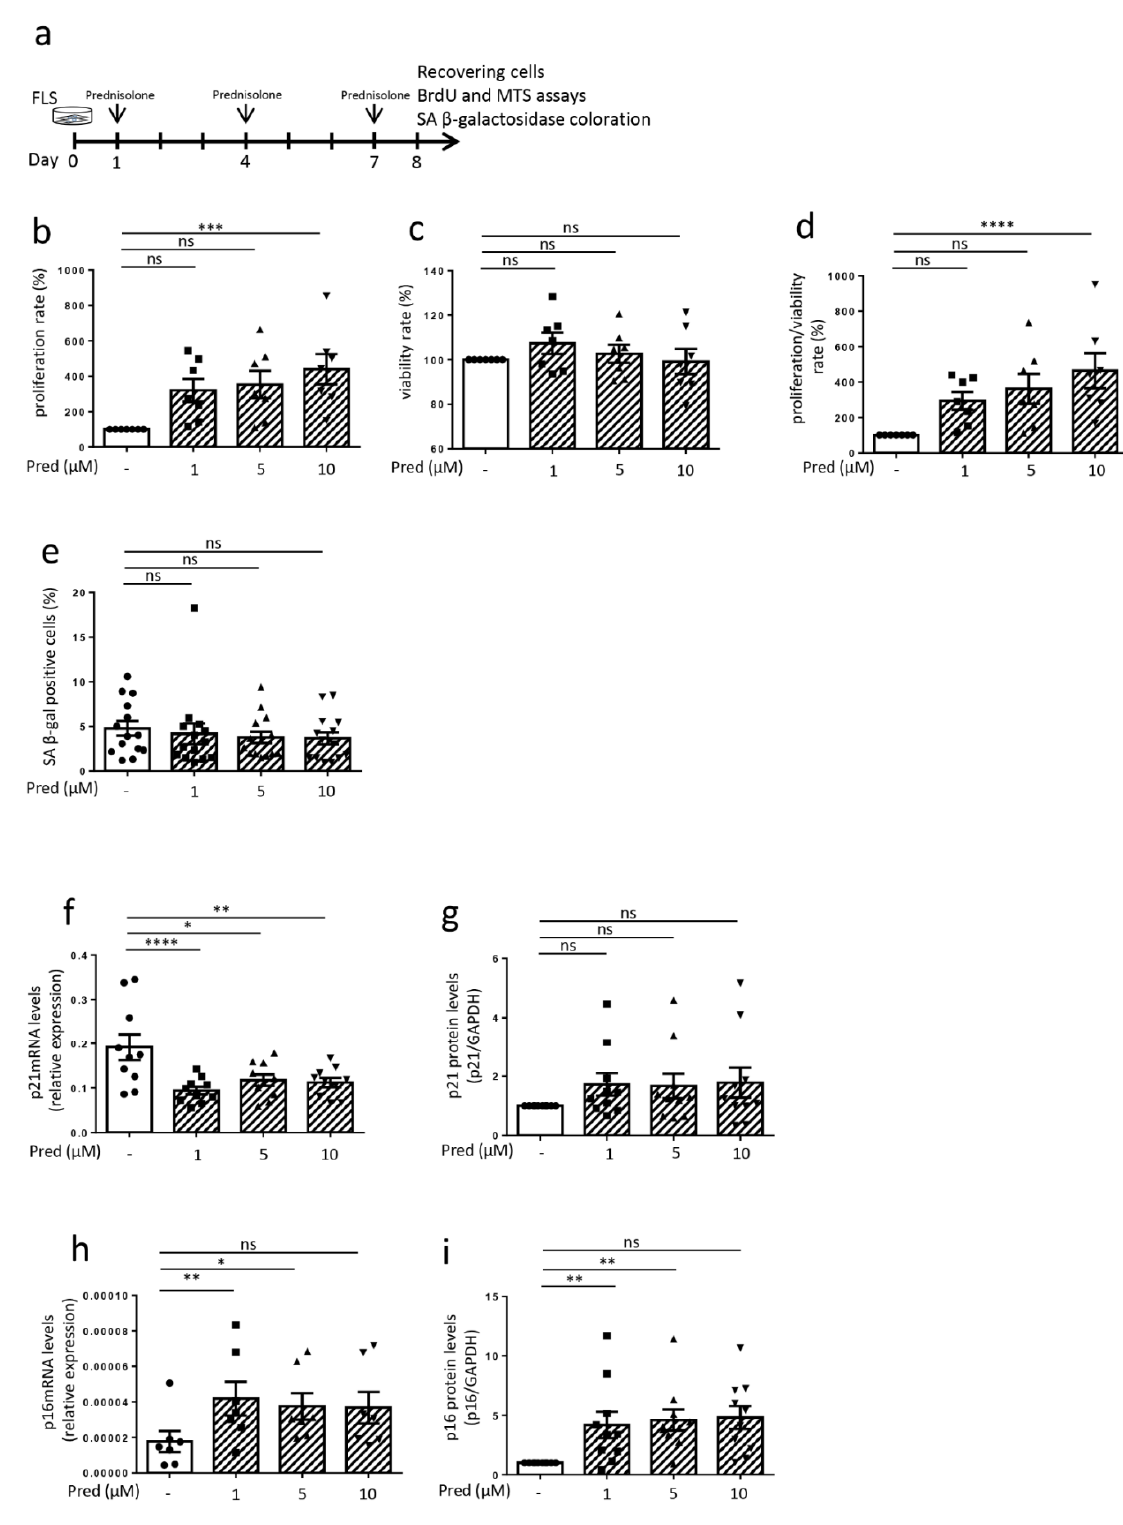
Figure 2. Effect of prednisolone on the hallmarks of senescence in osteoarthritic fibroblast-like synoviocytes at day 8. ( a ) Experimental design. ( b – d ) Proliferation rate analysis (BrdU incorporation), viability rate analysis (MTS analysis) and proliferation/viability ratio ( n = 7). ( e ) β -galactosidase staining ( n = 14). ( f , g ) p21 mRNA expression by RT-qPCR (data expressed as 2ˆ − ∆ Ct, n = 10) and protein expression by Western blotting (levels reported on GAPDH expression, n = 10). ( h , i ) p16 INK4A mRNA expression by RT-qPCR (data expressed as 2ˆ − ∆ Ct, n = 7) and protein expression by Western blotting (levels reported on GAPDH expression, n = 10). Results are expressed as mean ± SEM; * p < 0.05, ** p < 0.01, *** p < 0.001, **** p < 0.0001, ns = not